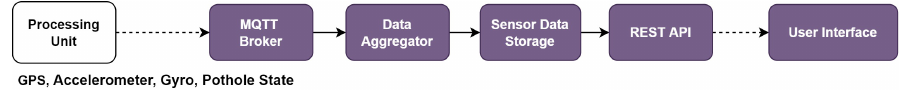
Figure 13. Function flow for road condition detection system in platform.